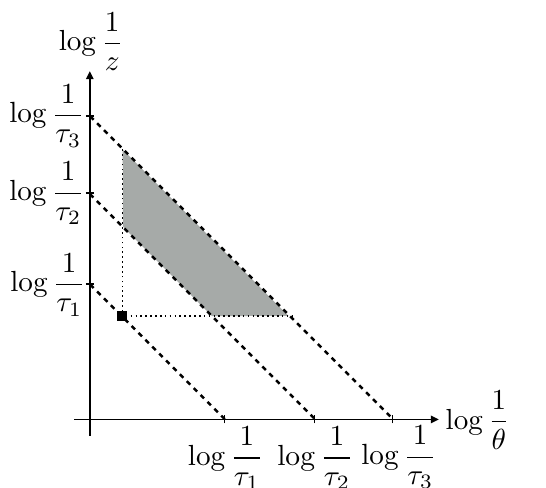
Figure 5. Illustration of the third of the forbidden regions (grayed) for gluon emission that sets the value of (cid:28) 3 , given a values of (cid:28) 1 and (cid:28) 2 . The location of the emission that sets the value of (cid:28) 1 in by the energy and angle of the primary gluon emission and by enforcing (cid:28) 2 < (cid:28) 3